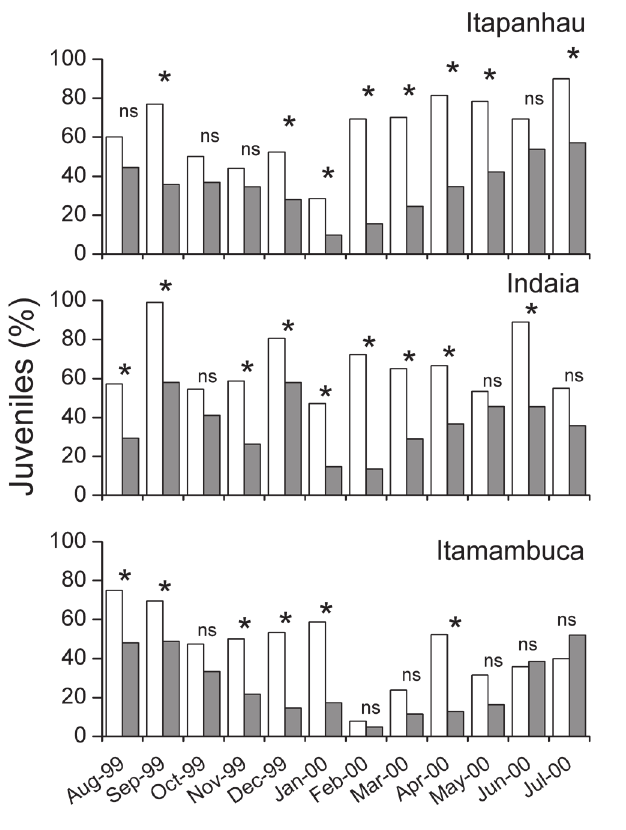
Figure 4. Minuca vocator (Herbst, 1804). Comparisons between proportions of juveniles obtained by CPUE (catch-per-unit- effort – gray columns) and QT (quadrat technique – white columns) throughout the year, in the studied mangroves. *, statistical significance. ns, no significant (z